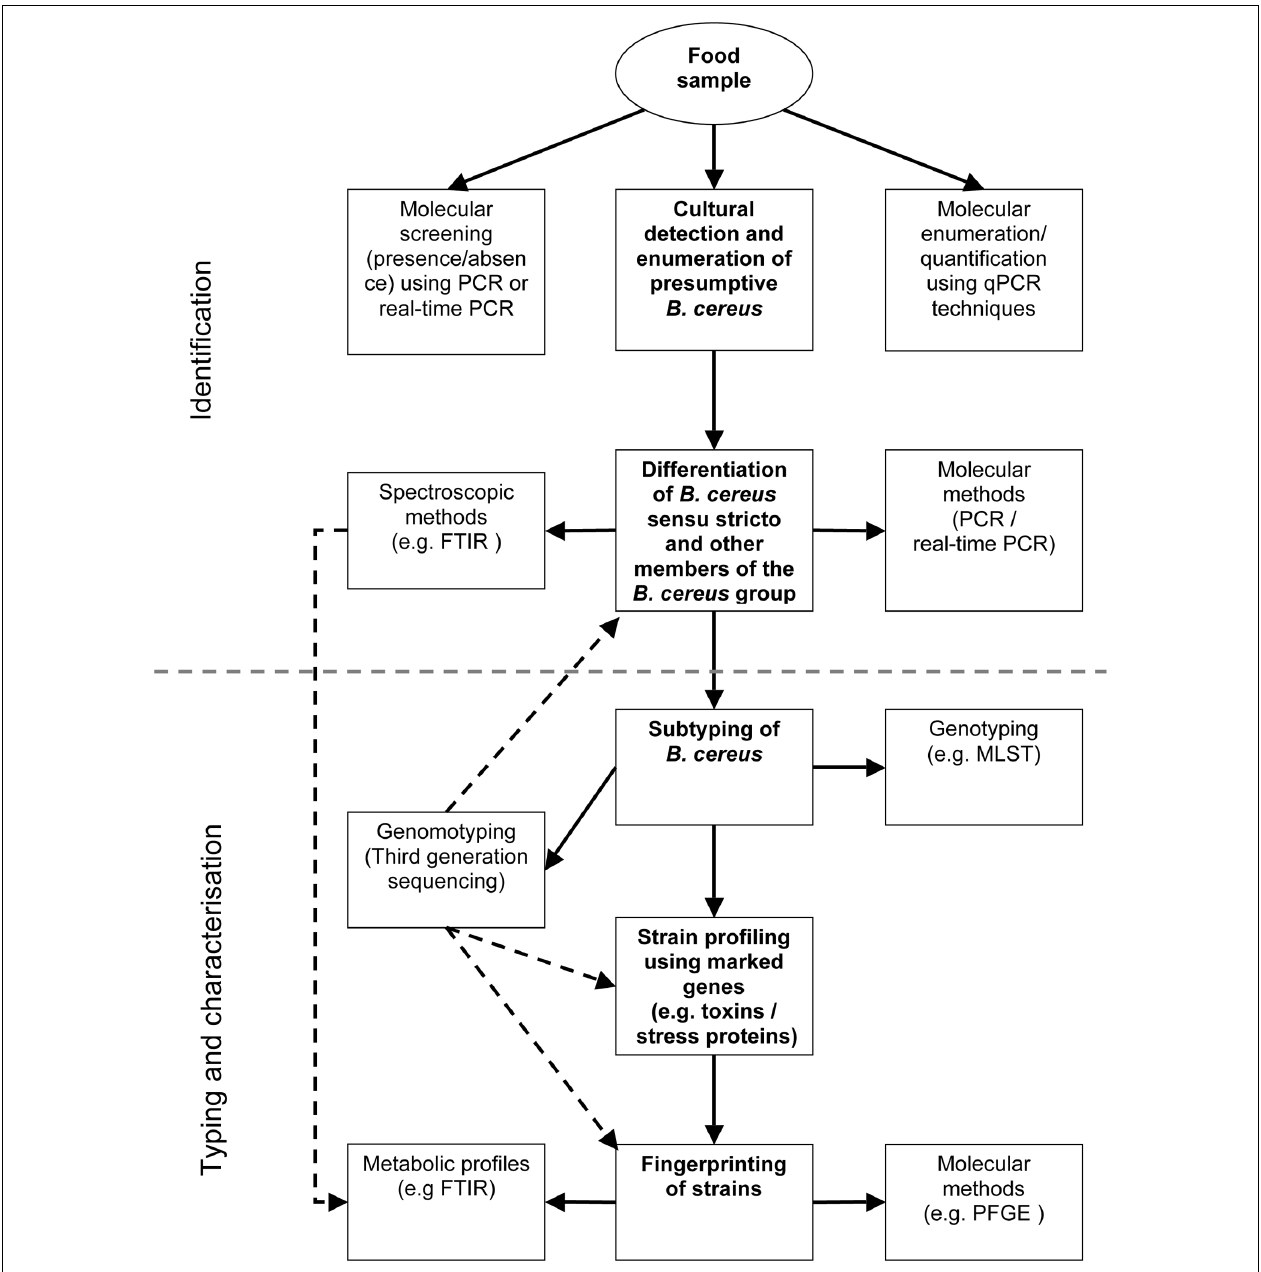
FIGURE 2 |Work flow for differential diagnostic of B. cereus s.l. in food samples. - - - - : spectral/sequence data generated once can be used for multiple analyses.